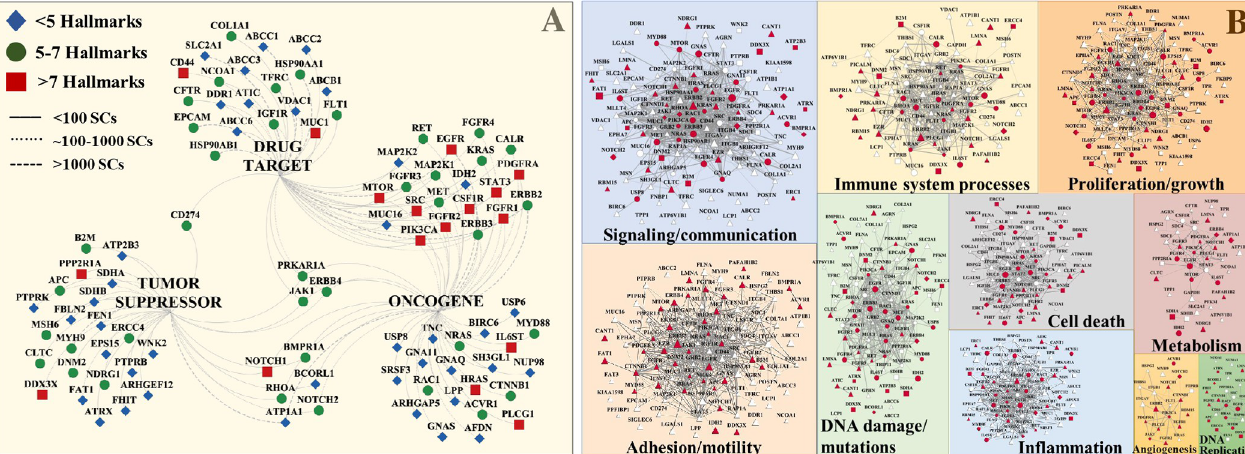
Fig 3. Drug targeting and PPI networks of 138 cell-membrane hallmark proteins. ( A ) Overlapping proteins between SKBR3 cell-membrane oncogenes, tumor suppressors, and drug targets. Top/left legend indicates the symbols of proteins matched to a particular number of hallmarks. Line width indicates the peptide spectral counts matched to each identified protein. ( B ) PPI networks constructed from 138 cell-membrane proteins matched to ten cancer hallmarks. CGC proteins are represented as oncogenes ( ◯ ), suppressors ( (cid:2) ), or oncogenes and suppressors ( ^ ); Red icons indicate whether the protein was annotated as a cancer hallmark protein by CGC; Other hallmark proteins ( 4 ); Node size is proportional to the protein abundance; Edge thickness reflects the STRING interaction score ( � 0.7).